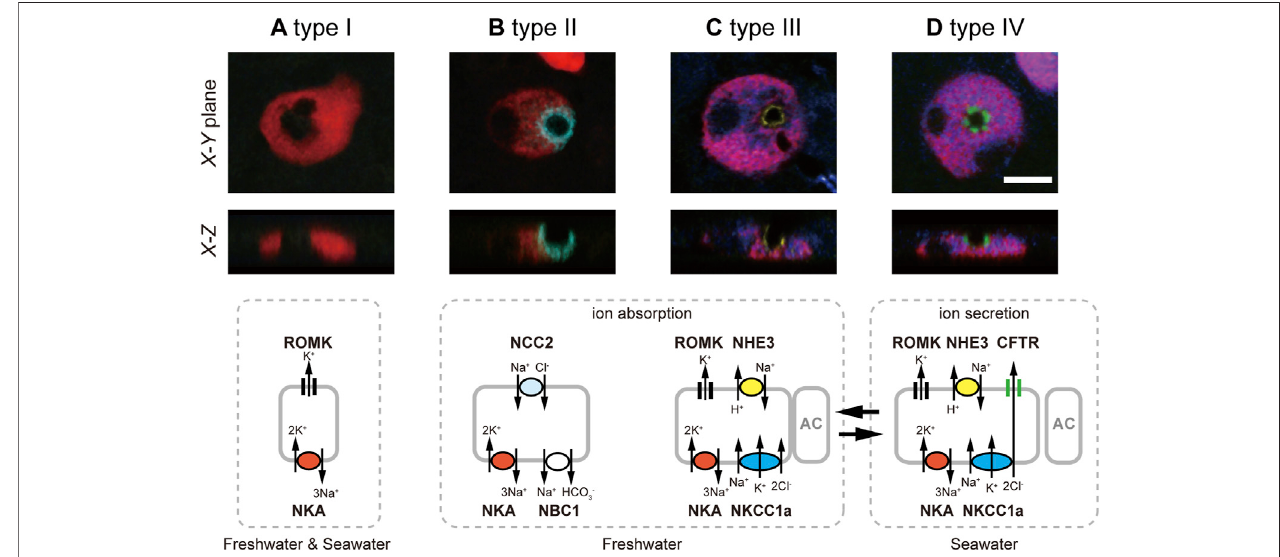
FIGURE 1 | Four types of ionocytes in the yolk-sac membrane of Mozambique tilapia embryos, by means of quintuple-color immuno fl uorescence staining: type-I (A) , type-II (B) , type-III (C) and type-IV (D) . Five images for NKA (red), NKCC1a (blue), NCC2 (cyan), NHE3 (yellow) and CFTR (green) are merged and shown in X – Y and X – Z planes. Type-I ionocytes show only basolateral NKA. Type-II ionocytes possess basolateral NKA and distinct apical NCC2. Type-III ionocytes are de fi ned by basolateral NKA, basolateral NKCC1a (red for NKA and blue for NKCC1a are merged into magenta), and apical NHE3. Type-IV ionocytes are provided with the threemajorion-transportingproteinsforsaltsecretion,basolateralNKA,basolateralNKCC1aandapicalCFTR.Scalebar,10 μ m.Schematicdiagramsofthe4 celltypes are presented in the bottom row, showing the apical or basolateral localization patterns of NKA (red), NKCC1a (blue), NCC2 (cyan), NHE3 (yellow) CFTR (green), NBC1 and ROMK. Modi fi ed from Hiroi et al.